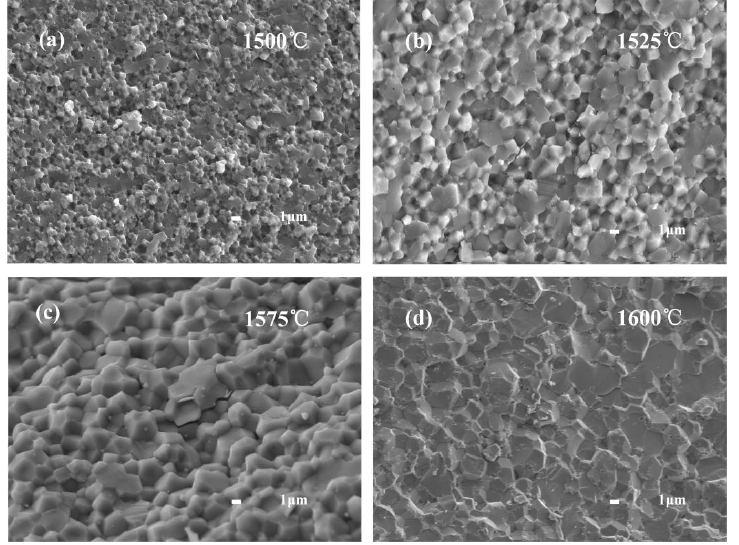
Figure 5. SEM images of the microstructure of the fracture surfaces of Al 2 O 3 -G-M hot-pressed at different sintering temperatures: ( a ) 1500 °C; ( b ) 1525 °C; ( c ) 1575 °C; ( d ) 1600 °C. Table 2. The average grain size and maximum grain size of Al 2 O 3 -G-M hot-pressed at different sin- tering temperatures.